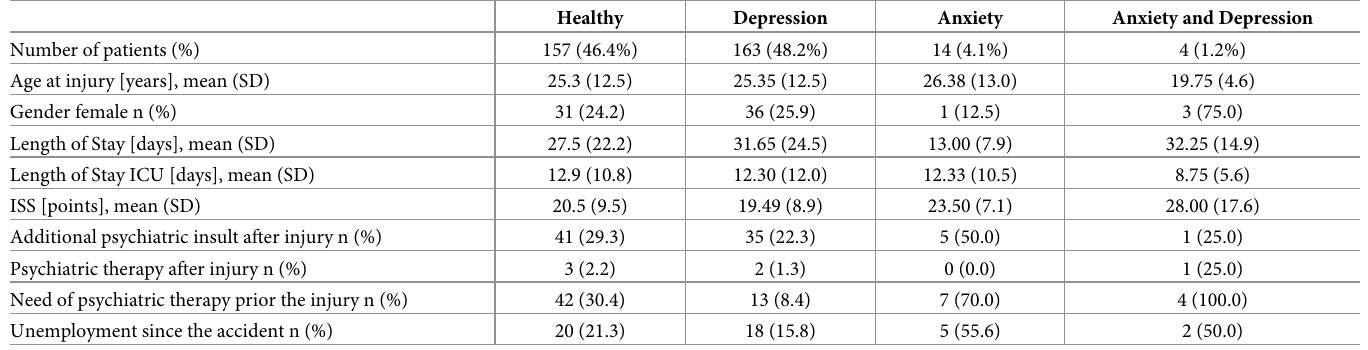
Table 2. Comparison of demographics of patients stratified according to psychiatric sequelae after injury. Stratification performed according to total score on HADS. Exploratory p-values based on ANOVA and chi-squared